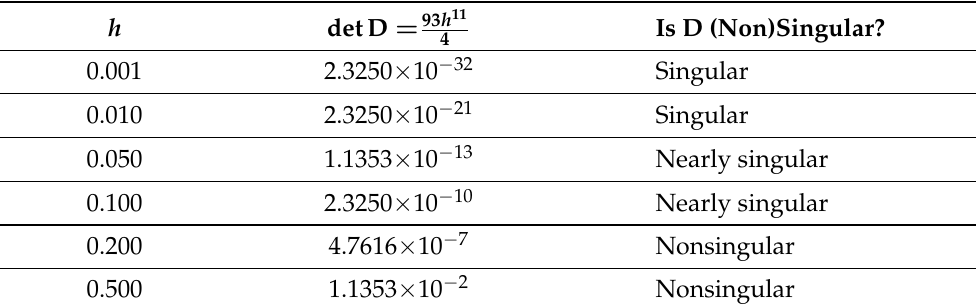
Figure 2. Optimal choices of grid points.